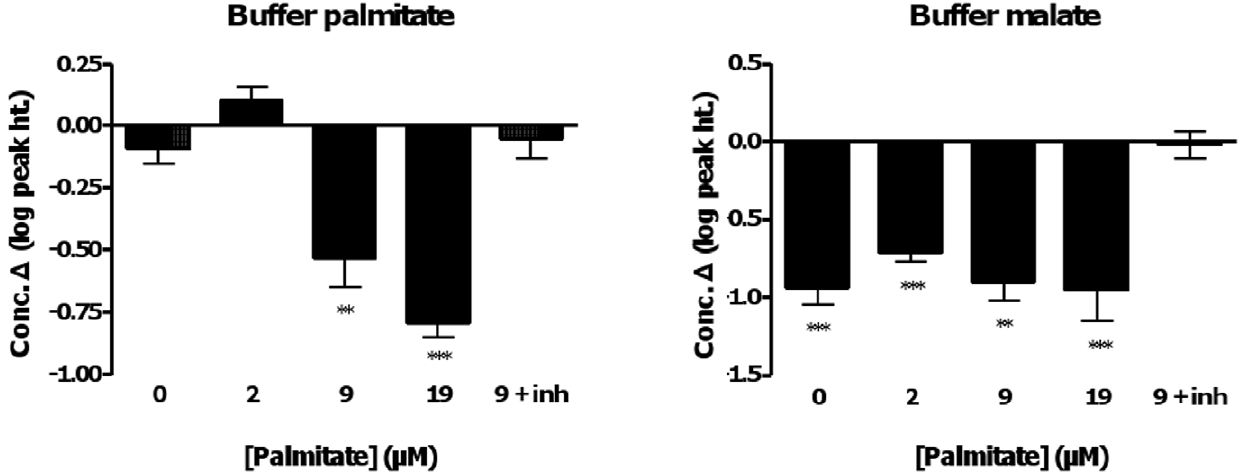
Figure 4. Change in the concentration of supplied substrates (palmitate, malate) in the buffer fraction obtained from murine muscle mitochondria over the course of the incubations. All 5 conditions are shown (0, 2, 9 and 19 m M palmitate, and 9 m M palmitate plus inhibitors). Values are the log of the change in concentration (peak height). Significance: paired t-test, 0 vs . 20 min, within treatment; * P , 0.05; **, P , 0.02, *** P ,